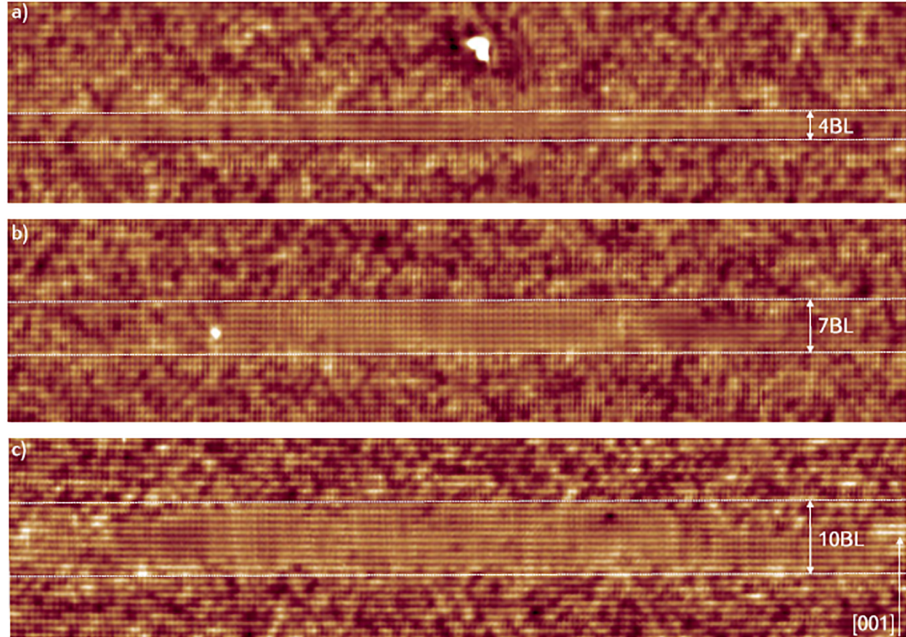
Figure 13. 68 × 15 nm 2 filled-state topography images of DE-QDs grown with the flushing procedure. ( a ) 2 nm AlGaAs partial capping. ( b ) 4 nm AlGaAs partial capping. ( c ) 4 nm AlGaAs partial capping + 2 nm GaAs QW. Adopted from Ref.